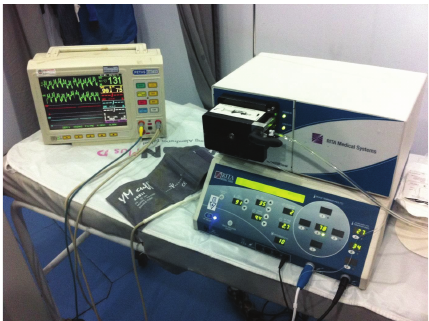
Figure 5: The electrode was connected to the RF generator and thermal ablation is